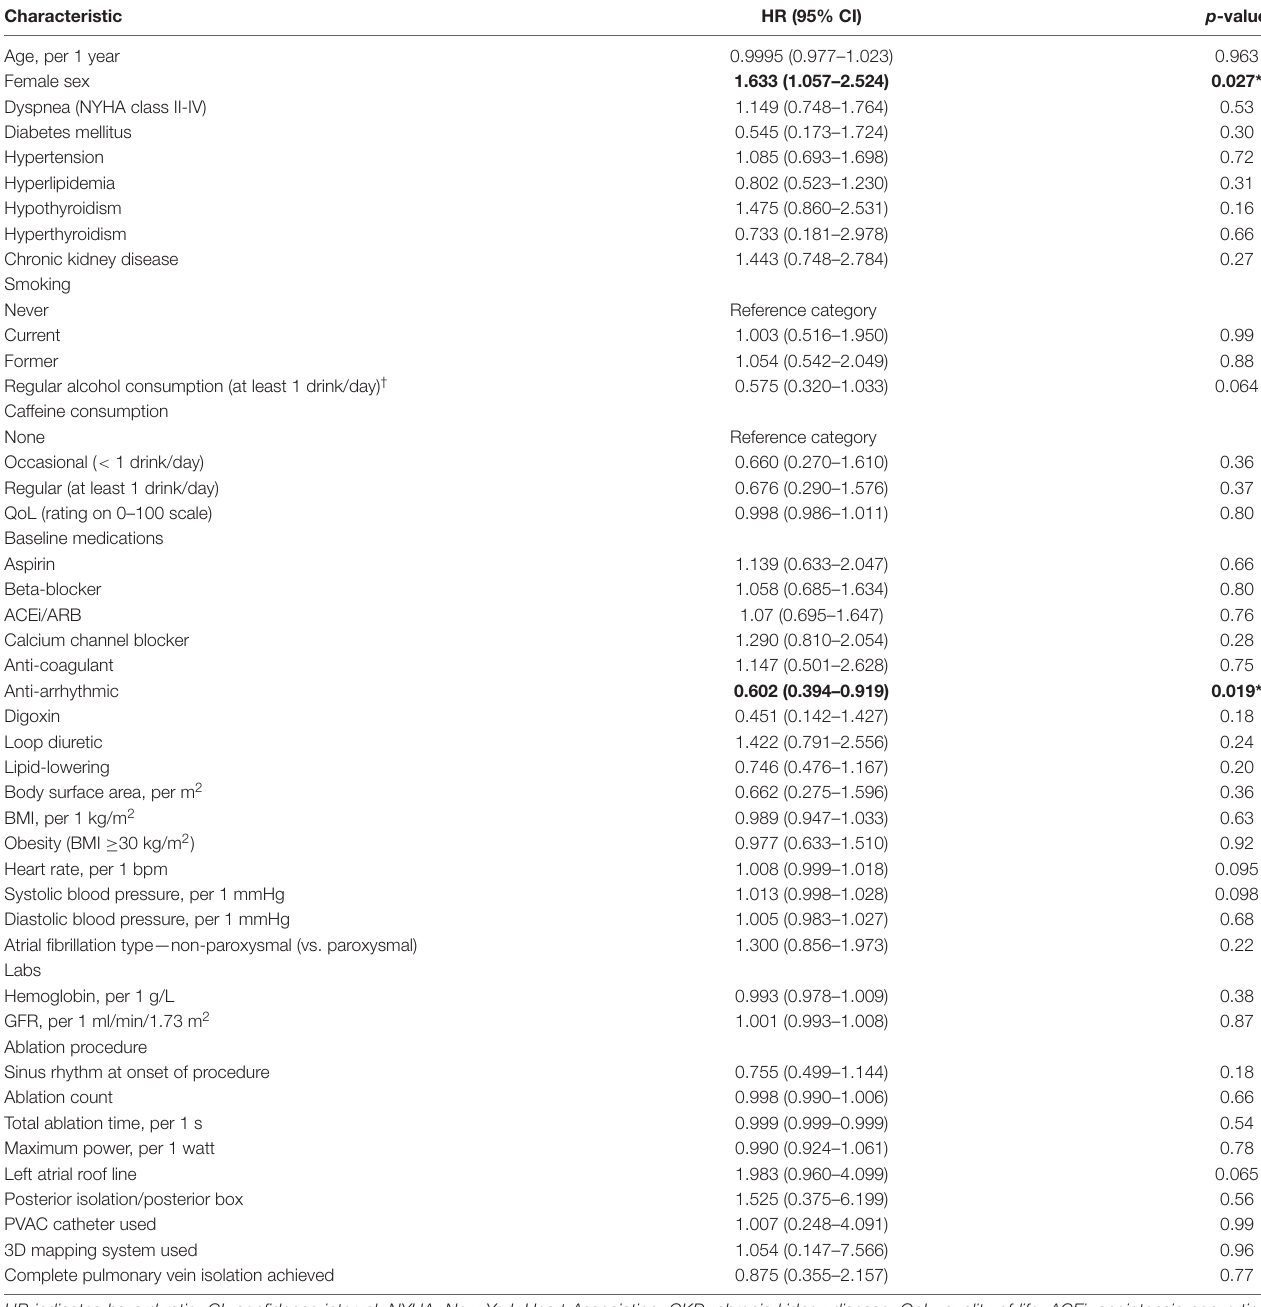
TABLE 4 | Univariable associations of non-imaging variables with the primary clinical outcome in the overall cohort (both sexes).